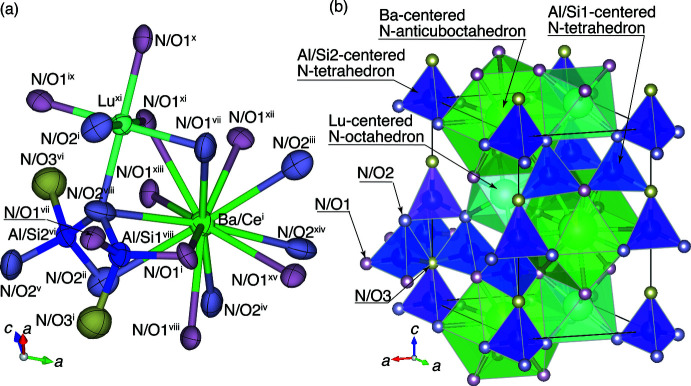
(a) Arrangement of cation-centered N/O atoms and (b) the crystal structure illustrated with cation-centered N/O-coordinated polyhedra for Ba0.90Ce0.10LuSi3.80Al0.20N6.90O0.10. Symmetry codes: (i) x, y, z; (ii) x − 1, y, z; (iii) x, y + 1, z; (iv) −y, x − y, z); (v) −y, x − y − 1, z; (vi) −x, −y, z + ); (vii) −y + 1, x − y, z); (viii) −x + y + 1, −x + 1, z; (ix) y, −x + y, z + ; (x) x − y + 1, x, z + ; (xi) −x + 1, −y + 1, z + ; (xii) y, −x + y + 1, z + ; (xiii) x − y, x, z + ; (xiv) −x + y + 1, −x + 2, z; (xv) −y + 1, x − y + 1, z.